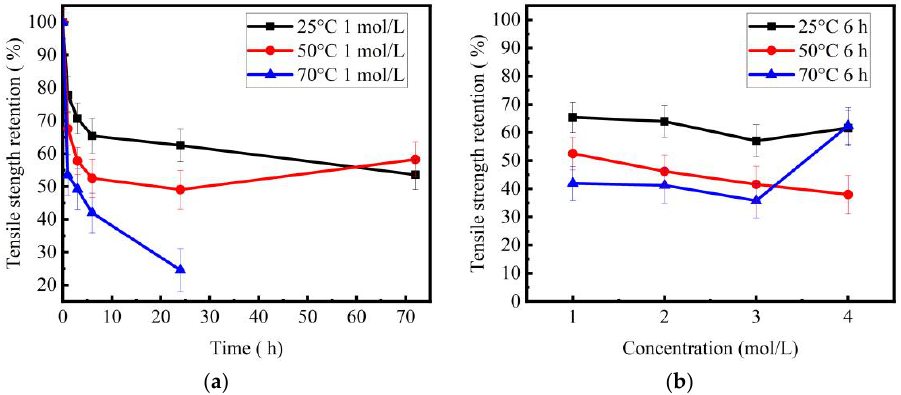
Figure 3. Tensile strength retention ratios of basalt fibers after NaOH solution treatment: ( a ) tensile strength retention ratios vs. corrosion time; ( b ) tensile strength retention ratios vs. concentration with 6 hr immersion.